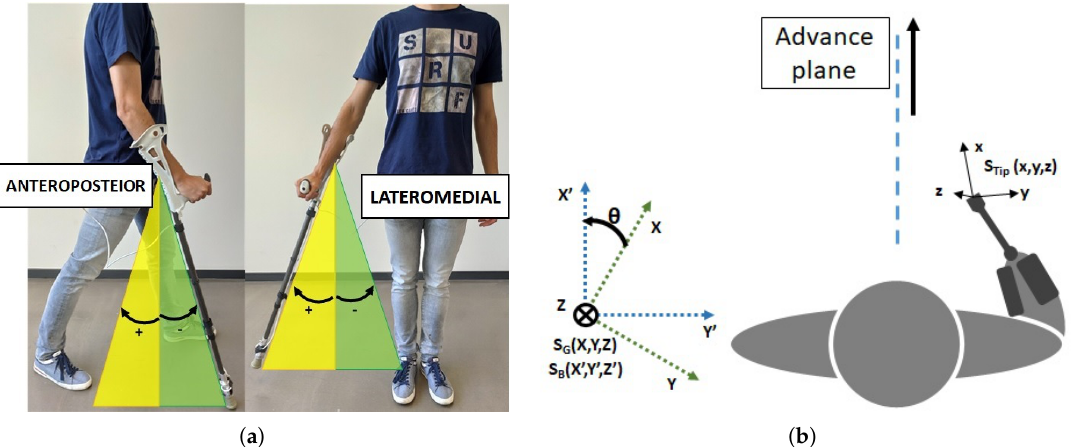
Figure 9. ( a ) Anteroposterior and Lateromedial angles. ( b ) Global, Body and Sensorized Tip reference